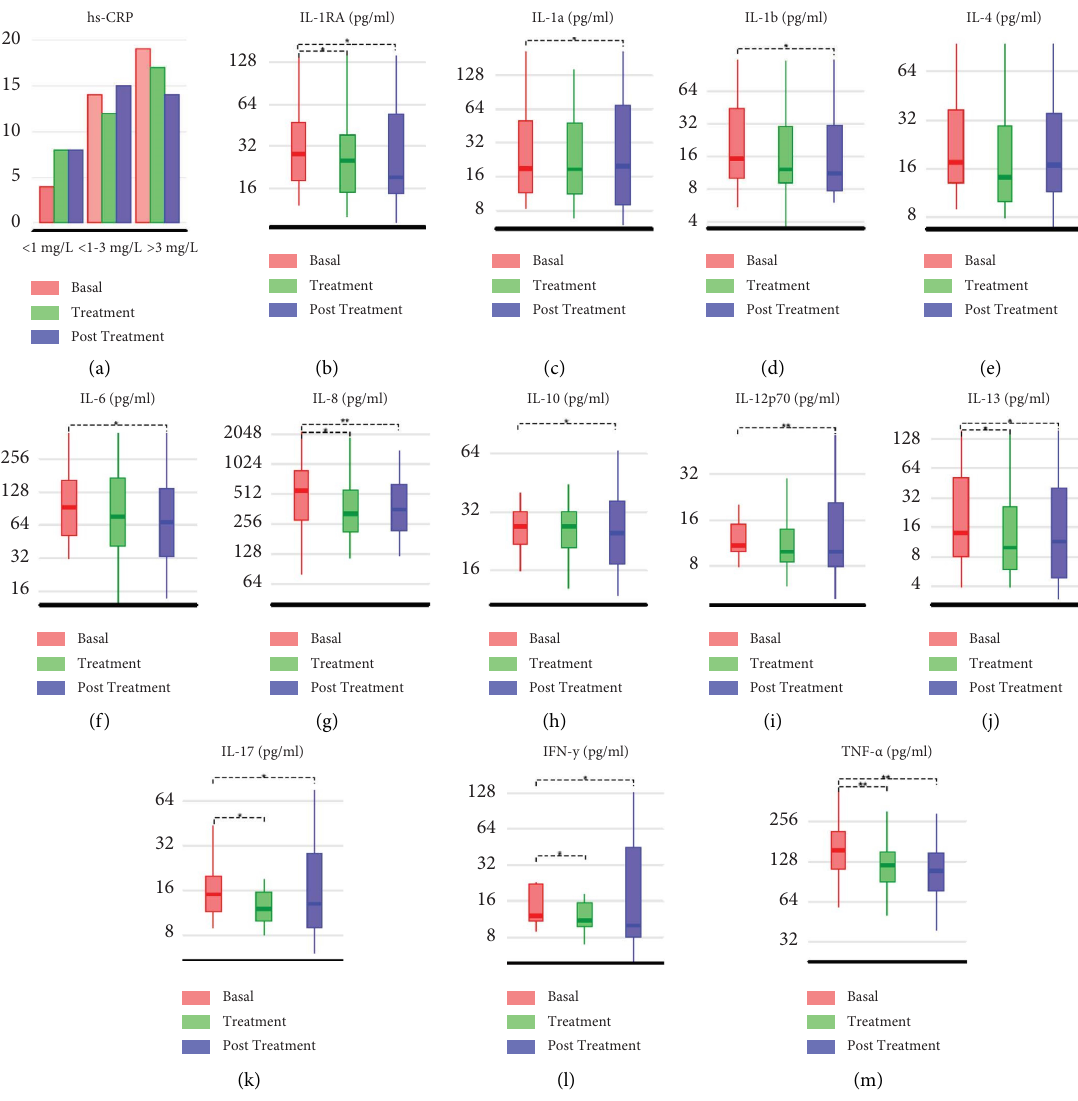
Figure 2: Infammatory parameters of patients in the periods studied. ∗ p < 0 . 05. ∗∗ p < 0 .